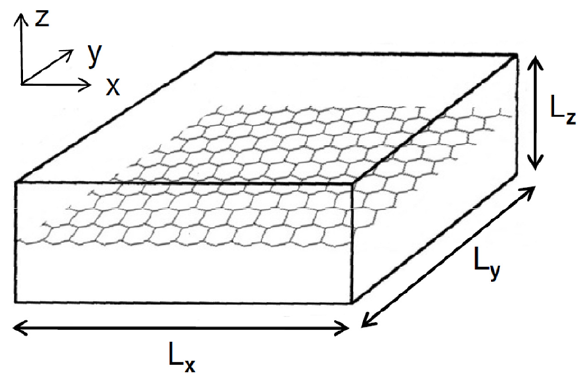
Figure 6. Determination of the permeability tensor for the capillary continuum. Hexagonal mesh of pulmonary capillaries embedded in a cuboid.